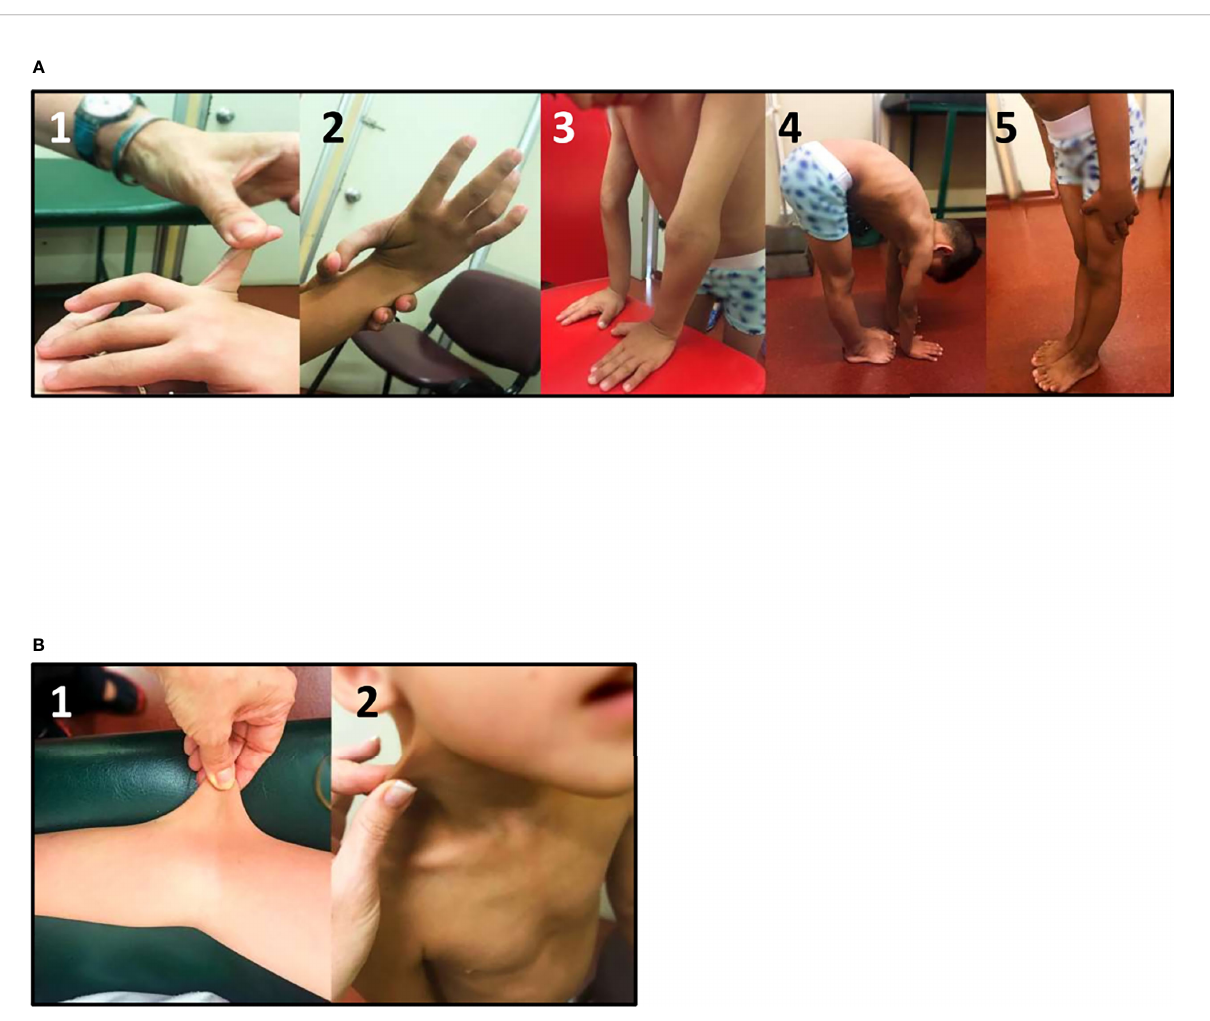
FIGURE 2 | Clinical evaluation of CAH-X Syndrome patients: (A) Generalized joint hypermobility Beighton score: 1) fi fth fi nger extension test, 2) wrist fl exion thumb abduction test, 3) elbow extension test, 4) trunk and hip fl exion test, and 5) knee extension test. (B) Skin extensibility can be measured by lifting the cutaneous and subcutaneous layers of the skin and is considered hyperextensible if it can be stretched over 1.5 cm at the forearm and the dorsum of hands, and 3 cm for neck, elbow, and knees. Photographs shown belong to a biallelic CAH-X patient (compound heterozygous for CH1 and